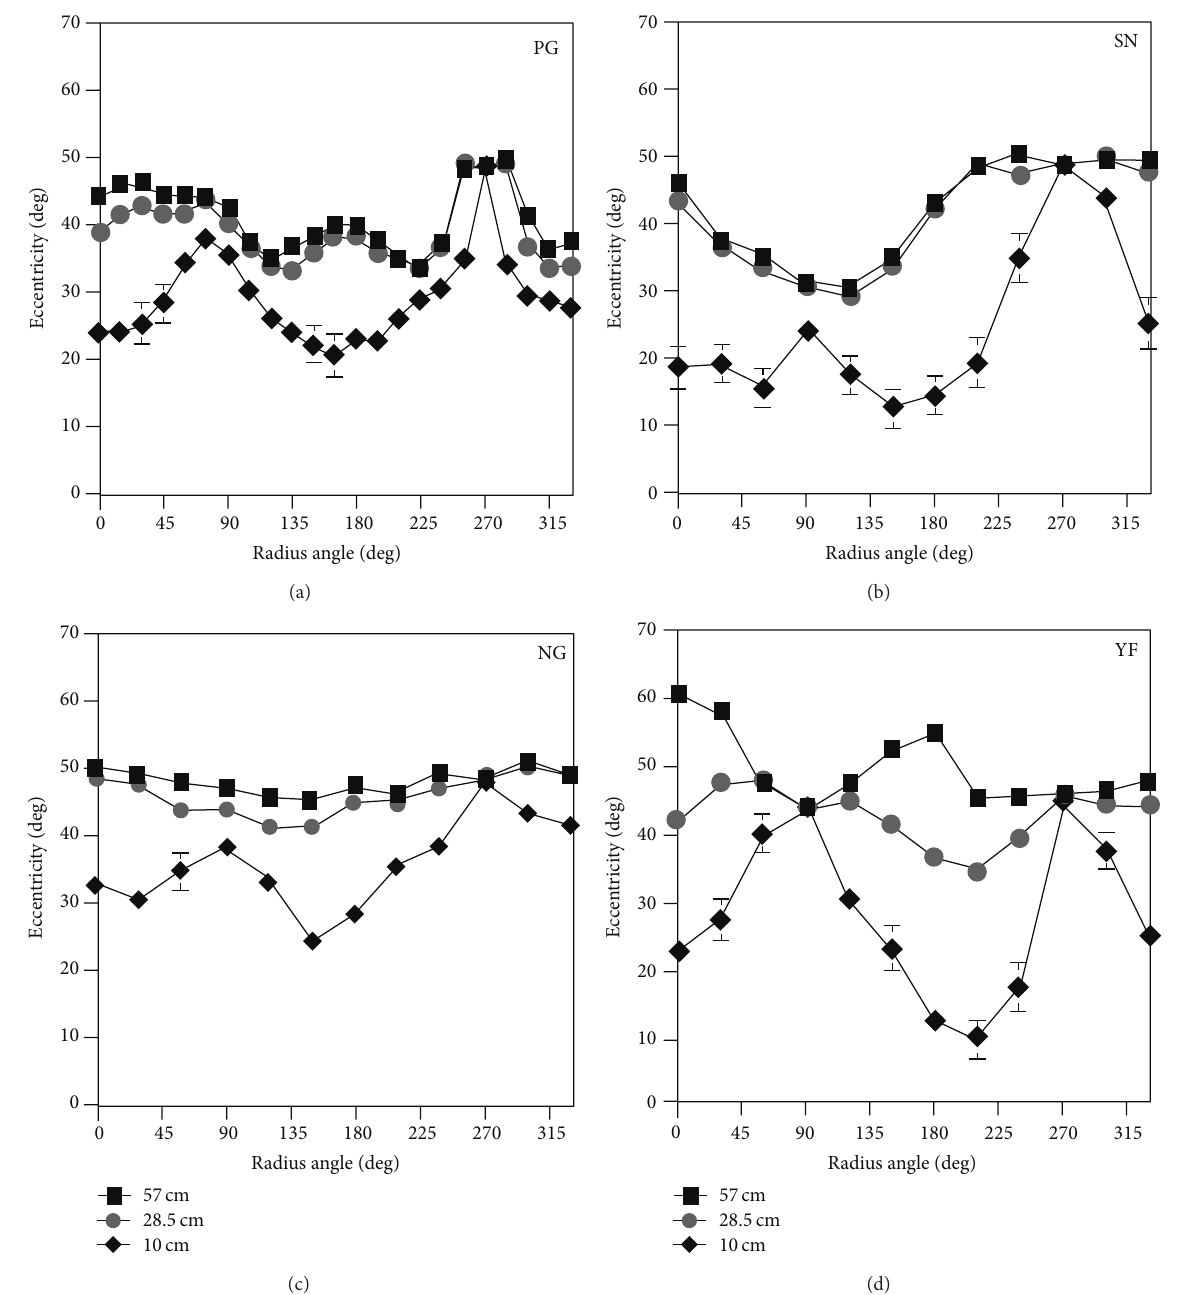
Figure 9: Individual Cartesian plots of the mean settings for “single to double” and “double to single” adjustments along each radius. Error bars represent ± 1